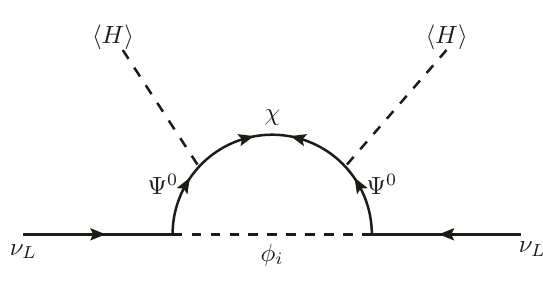
Figure 7 . Schematic diagram of radiative neutrino mass